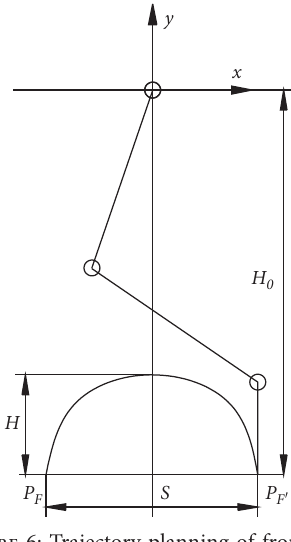
Figure 6: Trajectory planning of front